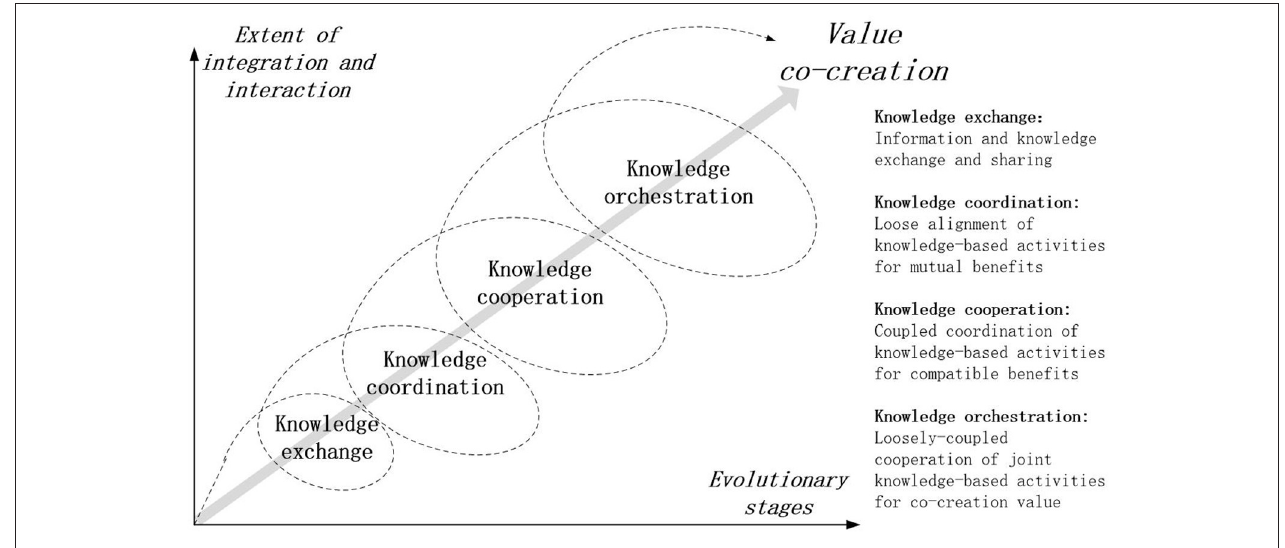
FIGURE 9 | Multi-stage orchestrating